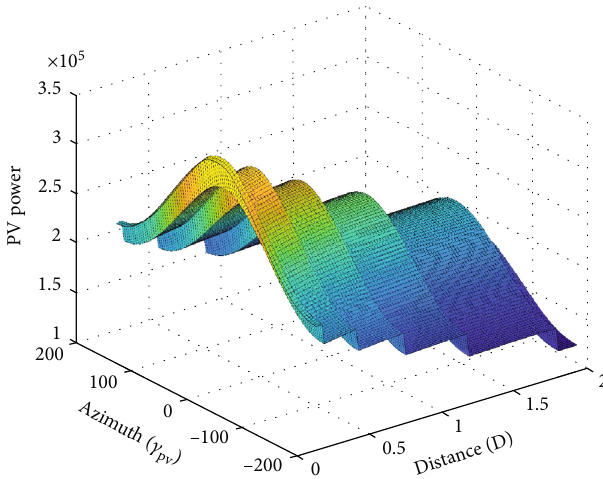
Figure 6: The e ff ect of SPV azimuth angle ( γ